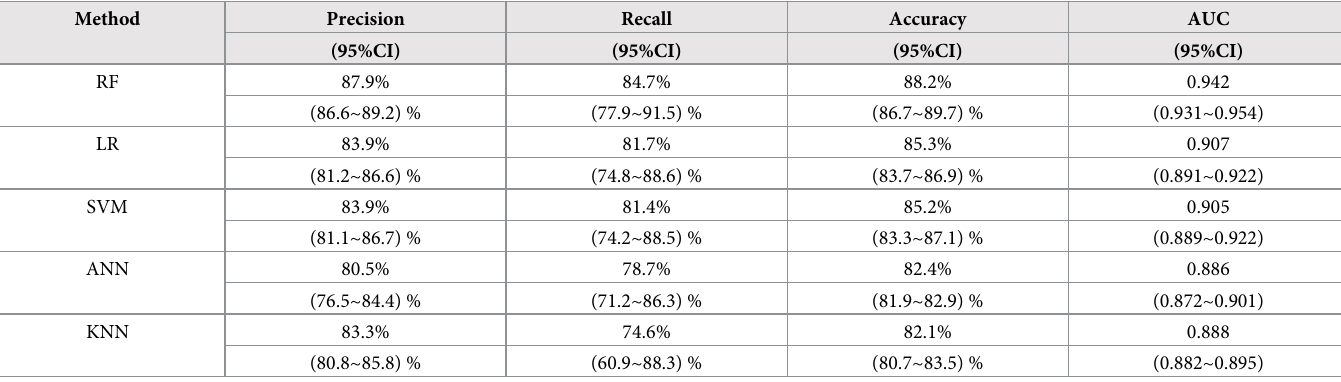
Table 4. Performance of five methods: NPC vs mix of 50% CRS and 50% controls.